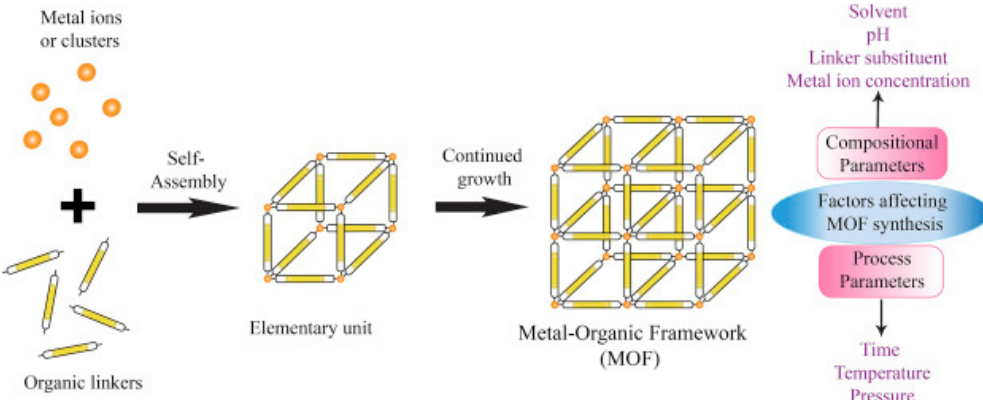
Figure 2. Total schematic of the building blocks of MOFs where metal clusters/SBUs (circles) coordinate with organic linkers (pegs/sticks) to form a homogenous repetitive crystalline framework [9].